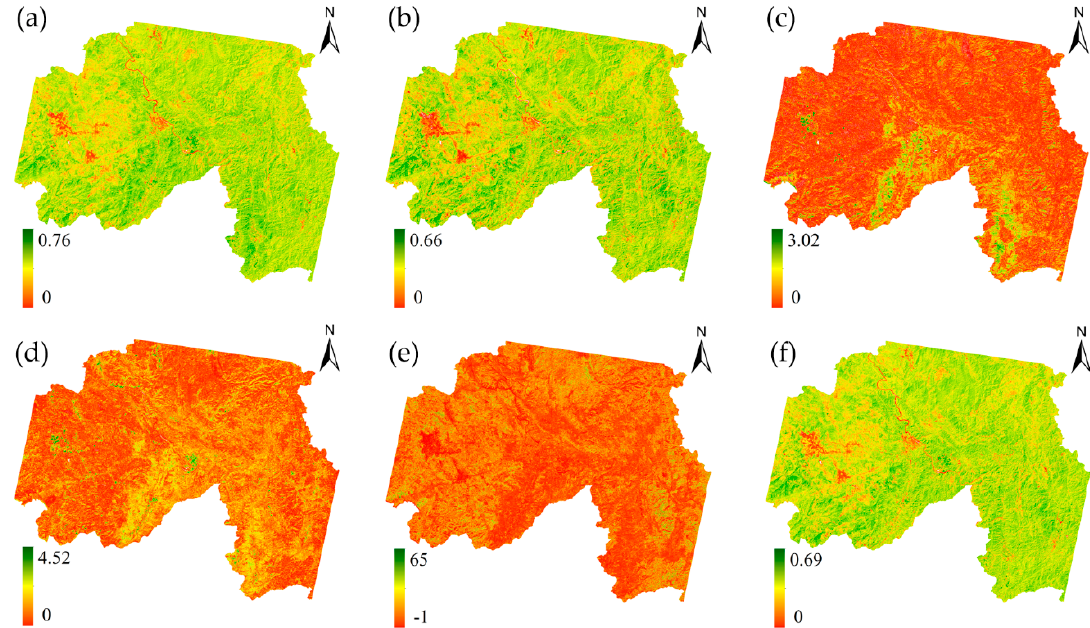
Figure 5. Six classification features of rubber plantations based on the EVI time series: ( a ) max EVI value; ( b ) min EVI value; ( c ) integral between DOY 001 and DOY 045; ( d ) integral of the EVI time series; ( e ) the ratio of max EVI to the integral of EVI, and ( f ) the EVI corresponding to the min derivative. Table 6. The maximum J-M distance between classes when 6 features are selected.